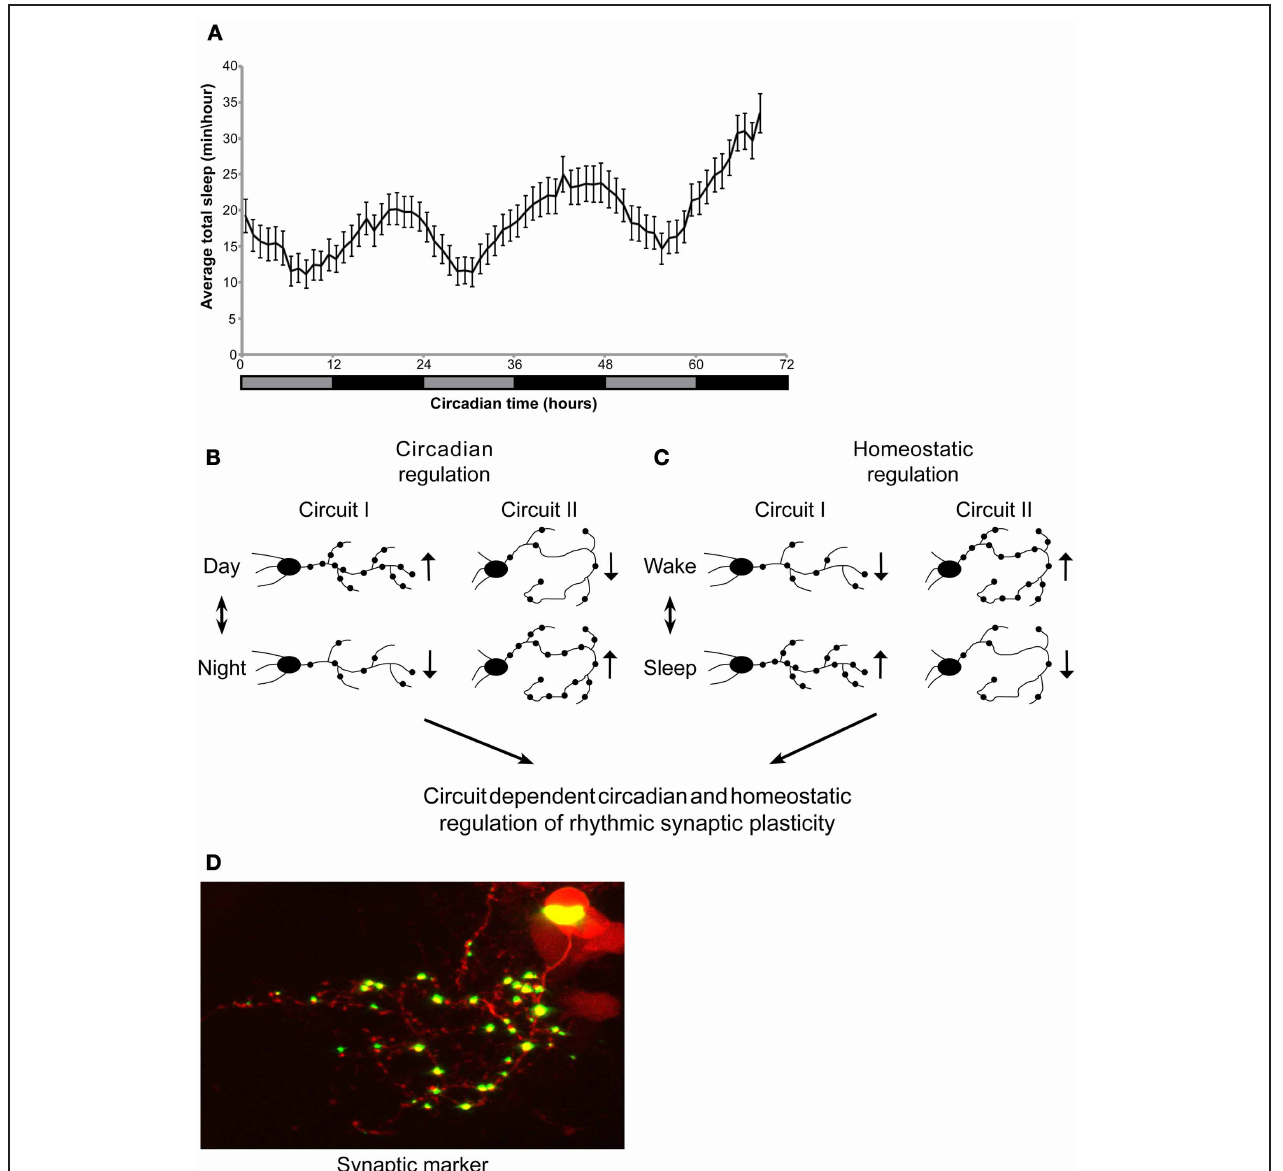
FIGURE 1 | Circadian regulation of sleep in larvae. Circadian and homeostatic (sleep-dependent) regulation of circuit-dependent rhythmic structural synaptic plasticity. (A) Zebrafish larvae were kept under LD for 6 days. At 6-8dpf, sleep was monitored under constant dim light for three consecutive days (gray and black bar represent subjective day and night, respectively). Sleep was defined and monitored as previously described (Elbaz et al., 2012). Sleep time was rhythmic and peaked during the night ( n = 55). (B,C) A proposed model demonstrating circadian and sleep/wake regulation of structural synaptic plasticity in the brain. Rhythmicity of synapse number, size and location is affected